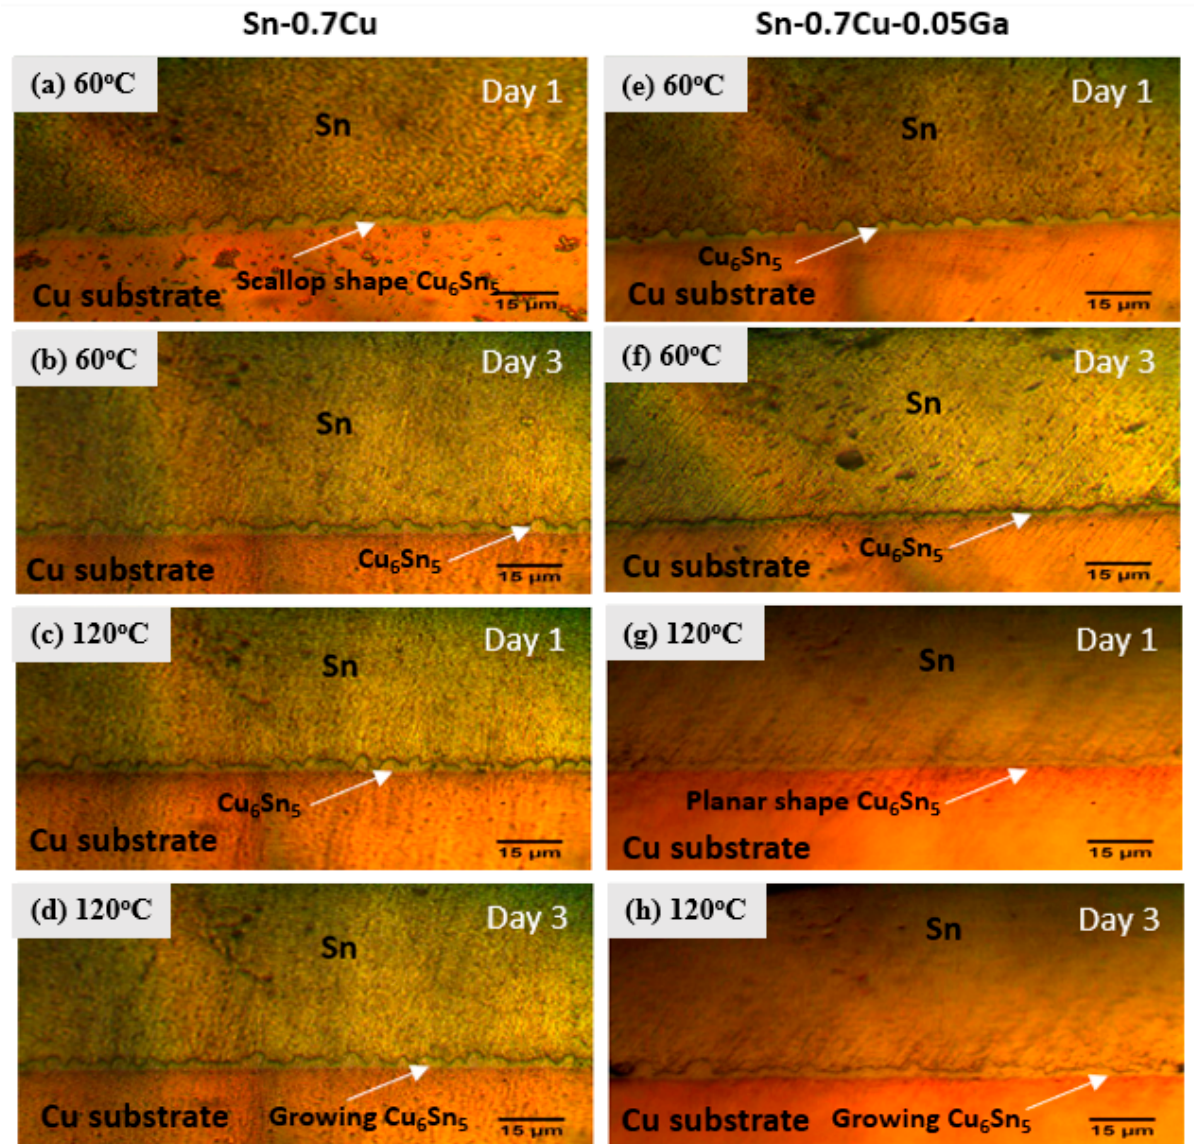
Figure 6. IMC formation of electromigration with thermal ageing of Sn–0.7Cu at ( a ) 60 °C for 1 day, ( b ) 60 °C for 3 days, ( c ) 120 °C for 1 day, and ( d ) 120 °C for 3 days; and Sn–0.7Cu–0.05Ga at ( e ) 60 °C for 1 day, ( f ) 60 °C for 3 days, ( g ) 120 °C for 1 day, and ( h ) 120 °C for 3 days.